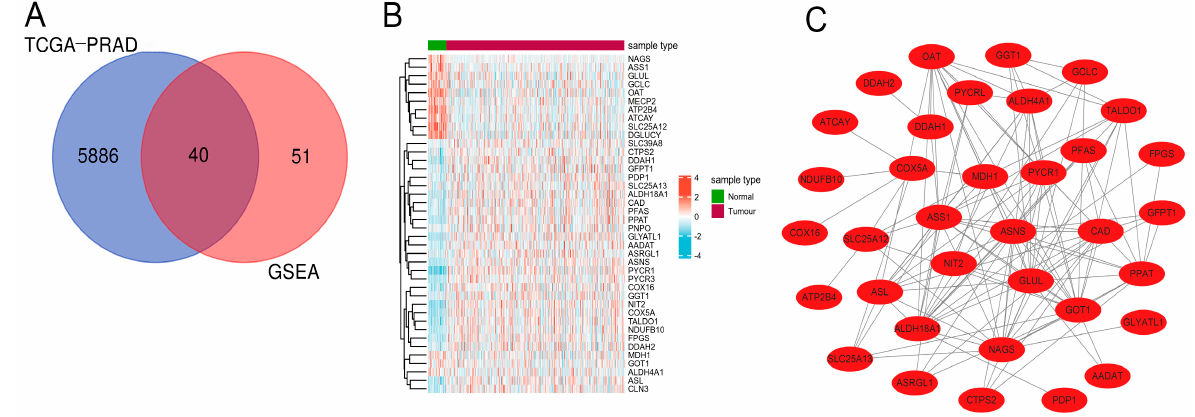
Figure 1. Preliminary screening and identification of PRAD-related DEGRGs. ( A ) The 40 DEGRGs overlapping from the TCGA and GSEA database are shown by Venn diagram. ( B ) The correlation Heatmap shows the expression difference of 40 DEGRGs. ( C ) PPI network of 40 DEGRGs. Table 1. Relevant clinical information of 422 PCa patients.